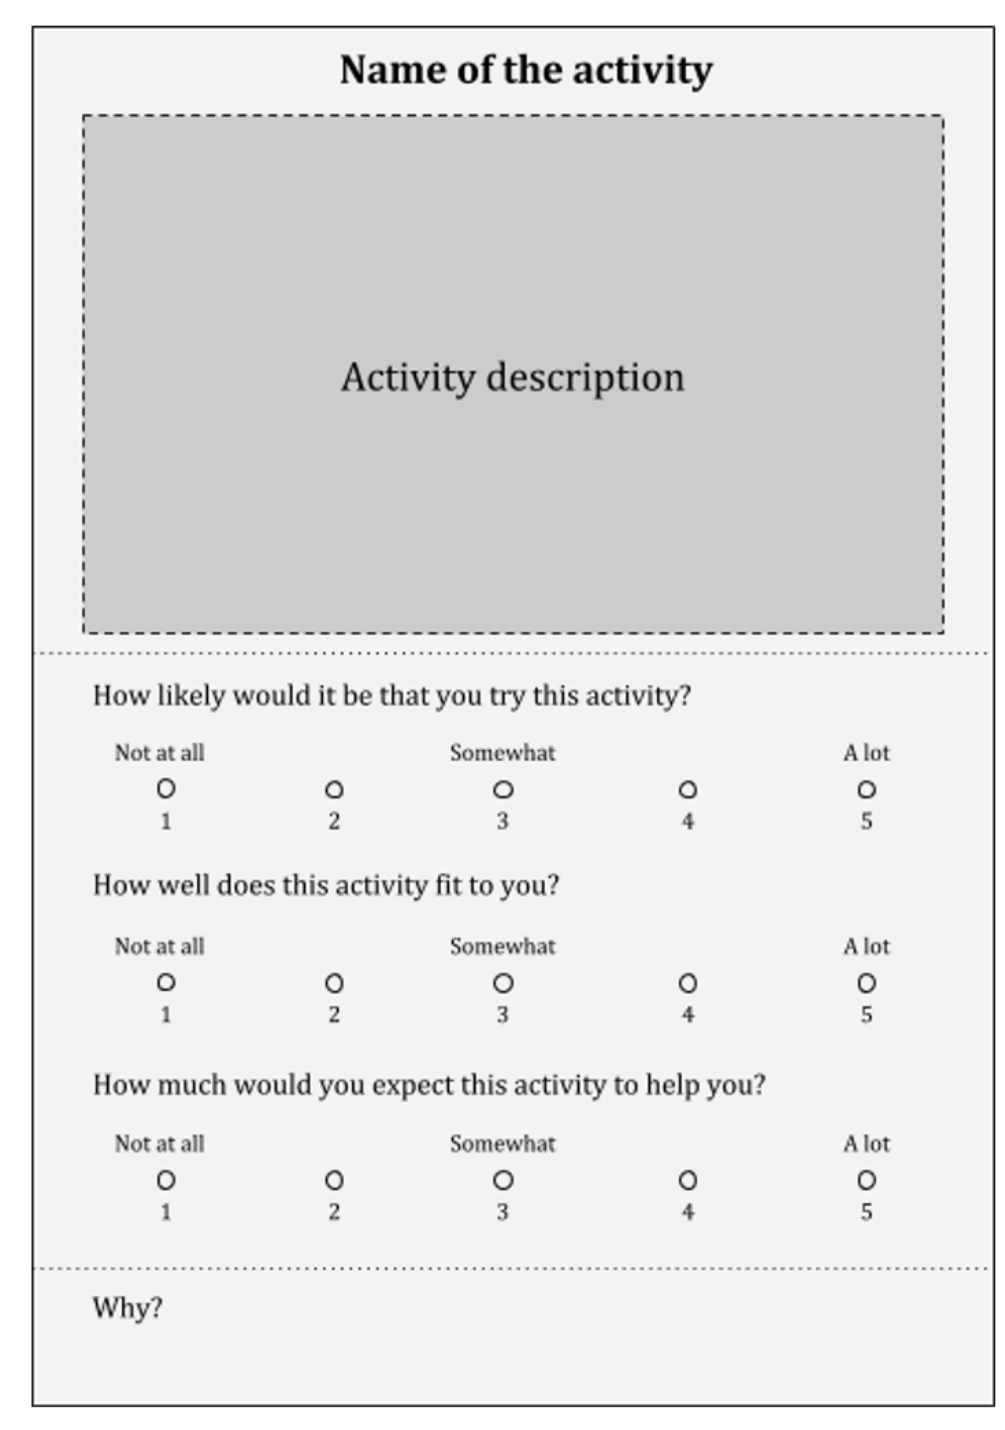
Figure 2. Intervention sheet